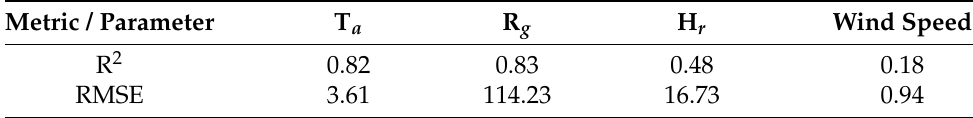
Table 2. Performance of univariate forecasting